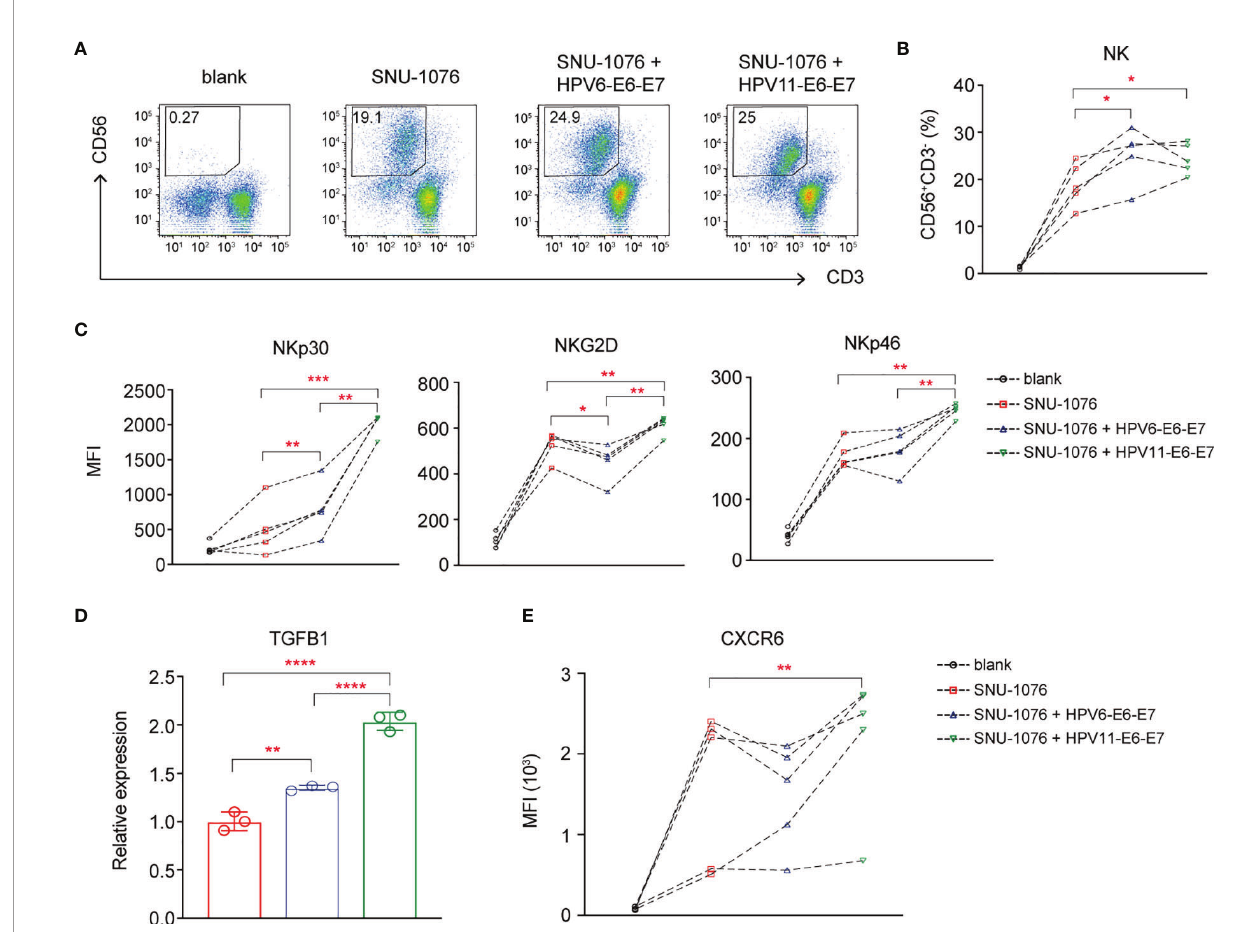
FIGURE 6 | The Human papillomavirus (HPV)6 and HPV11 E6 and E7 oncogenes affect NK cell cumulation and NK cell-activating receptor expression. PBMCs of HCs were cultured for 6 days with 100 U/ml IL-2 either in the absence (blank) or in the presence of the indicated SNU-1076 HNSCC cell lines. (A, B) Representative plots and percentage analysis of CD56 + CD3 - NK cells. (C, E) NKp30, NKG2D, and NKp46 expression on NK cells. (D) Relative expression of TGFB1 by RT-PCR. MFI, mean fl uorescent intensity. Blank, PBMCs alone; SNU-1076, PBMCs cocultured with SNU-1076 cell line; SNU-1076 + HPV6-E6-E7, PBMCs cocultured with HPV6-E6-E7-overexpressing SNU-1076 cell line; SNU-1076 + HPV11-E6-E7, PBMCs cocultured with HPV11-E6-E7-overexpressing SNU-1076 cell line. Each dot represents a single individual. *P < 0.05; **P < 0.01; ***P < 0.001; ****P <